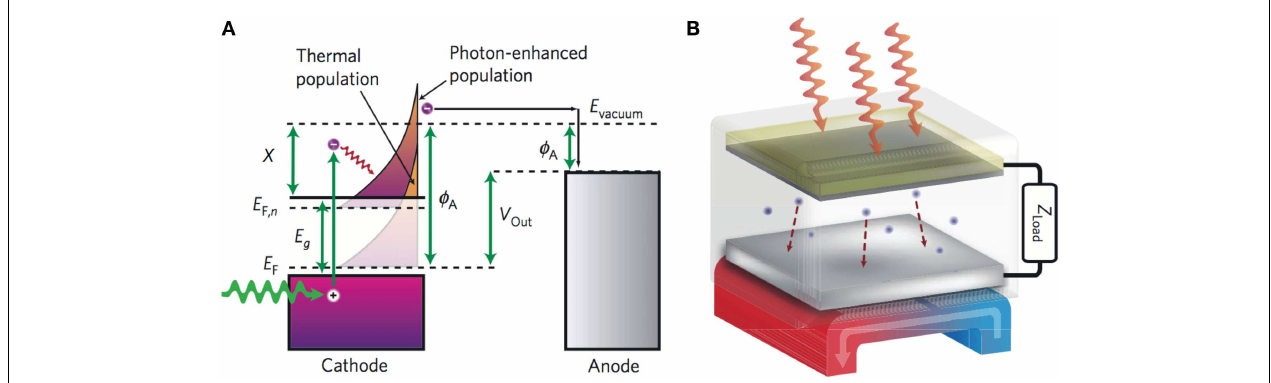
FIGURE 10 | (A) Energy diagram of the PETE process. (B) A schematic of a possible parallel-plate PETE converter. Reprinted with permission from Schwede et al. (2010).